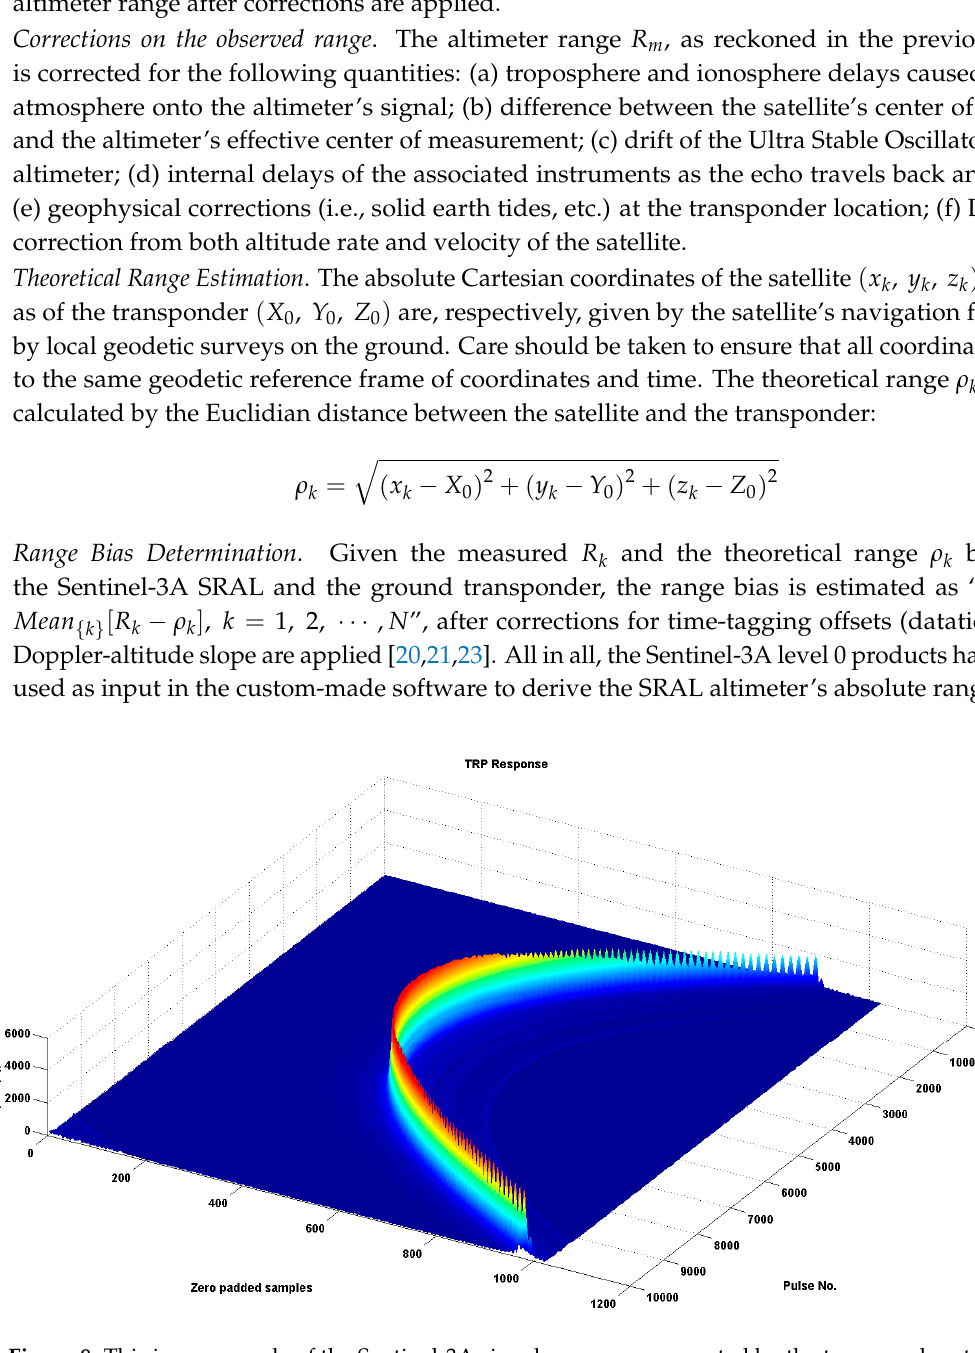
Figure 8. This is an example of the Sentinel-3A signal responses generated by the transponder at the CDN1 Cal/Val site on 21 December 2017, at the mountains of West Crete. Calibrated Synthetic Aperture Radar (SAR) data, shown as a Fast Fourier Transform, are plotted against zero-padded samples and Ku-pulse index in Cycle No.26 of Sentinel-3A. The Pulse Repetition Internal for Sentinel-3A has been 17,800 Hz within a burst and the burst repetition interval is 80 Hz. Relative scale of signal magnitude is shown in color on the vertical bar (arbitrary units).